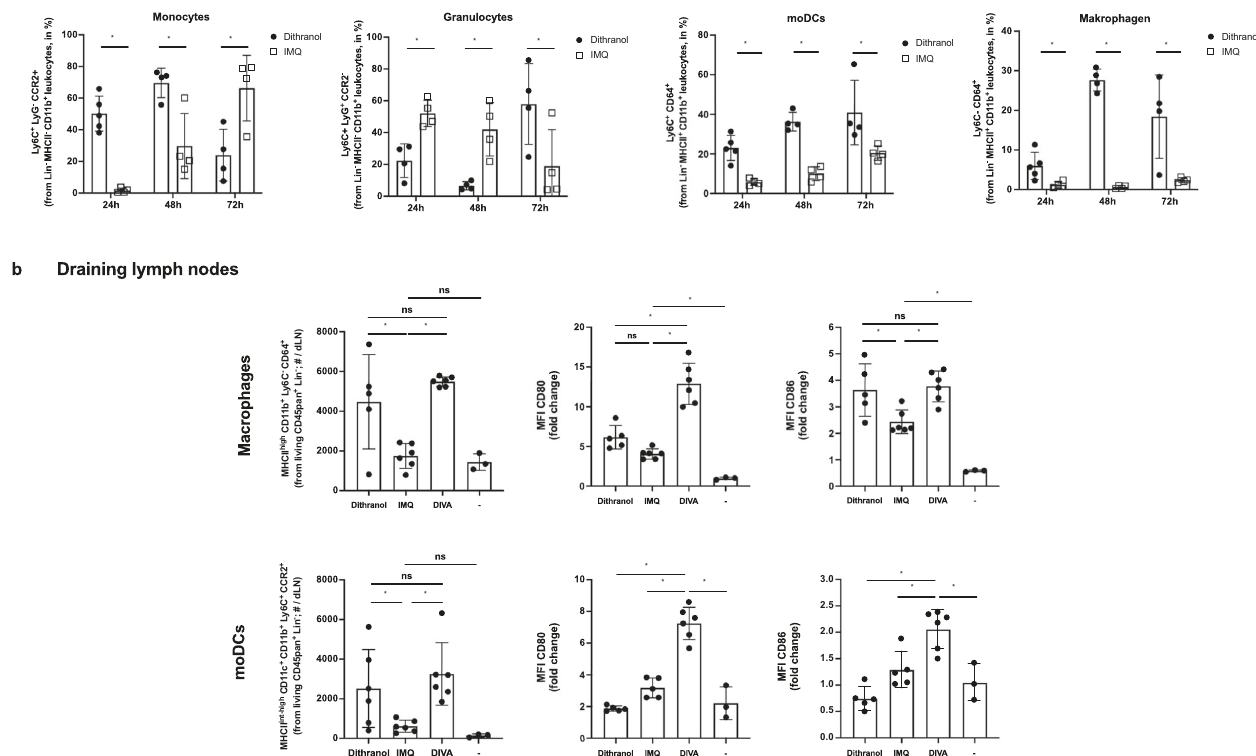
Fig. 6 Dithranol induces early monocyte recruitment into the skin and accumulation of monocyte-derived DCs and macrophages in the draining lymph nodes. a Mice were treated once with dithranol or IMQ on both ears. After 24 h, the ears were digested with collagenase type IV in a GentleMACS dissociator. The percentages of monocytes (MHCII − CD11b + Ly6C + Ly6G − CCR2 + ), granulocytes (MHCII - CD11b + Ly6C + Ly6G + CCR2 − ), monocyte-derived DCs (MHCII + CD11b + Ly6C + CD64 + ) and macrophages (MHCII + CD11b + Ly6C − CD64 + ) in the living lineage- negative leukocytes in the skin were determined by fl ow cytometry (Supplementary Fig. 1e). b Mice were treated once with dithranol, IMQ or DIVA as before. After 72 h, auricular lymph nodes were harvested from treated mice and were then digested with collagenase type IV for 60 min on a heat shaker. The total number of monocyte-derived DCs (MHCII + CD11b + Ly6C + CD64 + ) and macrophages (MHCII + CD11b + Ly6C − CD64 + ) and the particular expression of co-stimulatory molecules in the auricular lymph nodes were determined by a Scil Veterinary Excellence cell counter and fl ow cytometry (Supplementary Fig. 1f). Bars represent mean and SD of data collected from at least two independent experiments. *Signi fi cant difference with p < 0.05 by T test ( a ) or one-way ANOVA with Bonferroni ’ s posttest ( b